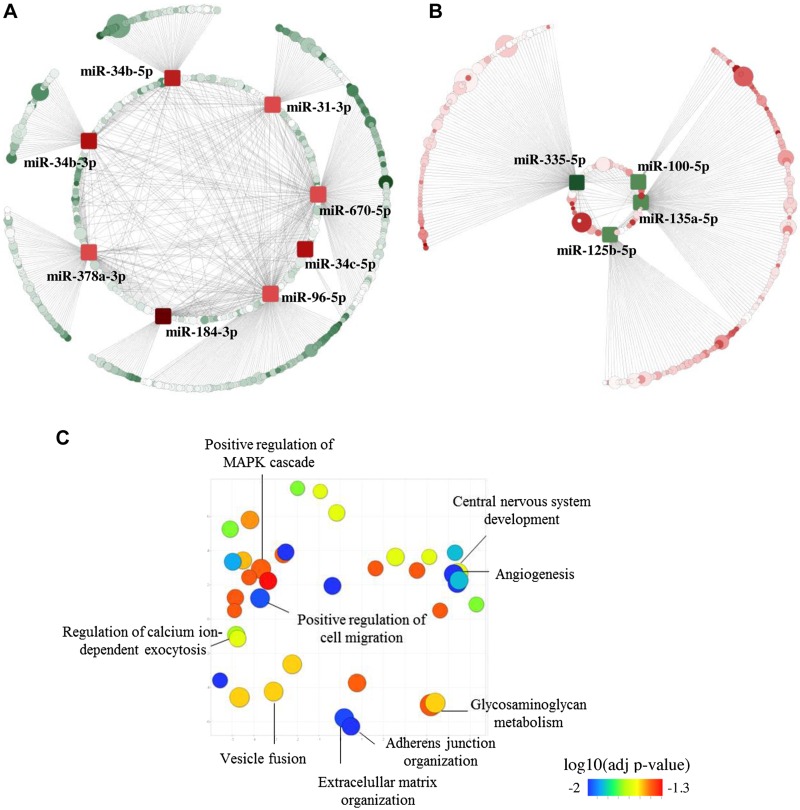
miRNAs regulated by AMPK are involved in pathways important for β-cell function. A, B) Cytoscape-generated layout of down-regulated (square, red nodes) (A) and up-regulated (square, green nodes) (B) miRNAs and their predicted targets that are up-regulated (circle, green nodes) (A) and down-regulated (circle, red nodes) (B), respectively, in βAMPKdKO vs. control islets. Node size represents the degree of the fold change (the larger, the stronger). The intensity of the gene node color (circles) indicates the target prediction score according to TargetScan (the darker, the stronger). A full list of miRNA and targets can be found in Supplemental Tables 2 and 3. C) REViGO Scatterplot of the enriched GO terms. Up-regulated targets of down-regulated miRNAs (Supplemental Table 2) in βAMPKdKO islets were submitted to EnrichR, which identified enrichment in 37 (Supplemental Table 4) biologic processes (adjusted P < 0.05). GO terms along with their adjusted significance values (P < 0.05) are represented by circles and are plotted according to semantic similarities with other GO terms. Circle size is proportional to the frequency of the GO term, and circle color represents the adjusted significance value calculated using EnrichR.